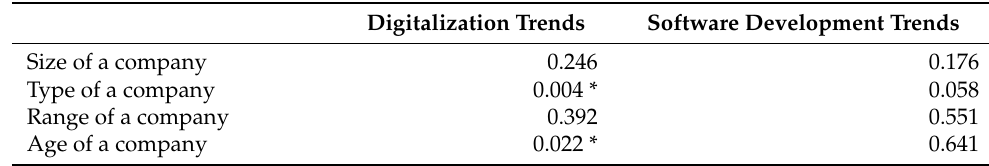
Table 7. Group comparison: company characteristics vs. importance of development trends— p -value determined by Mood’s median test.